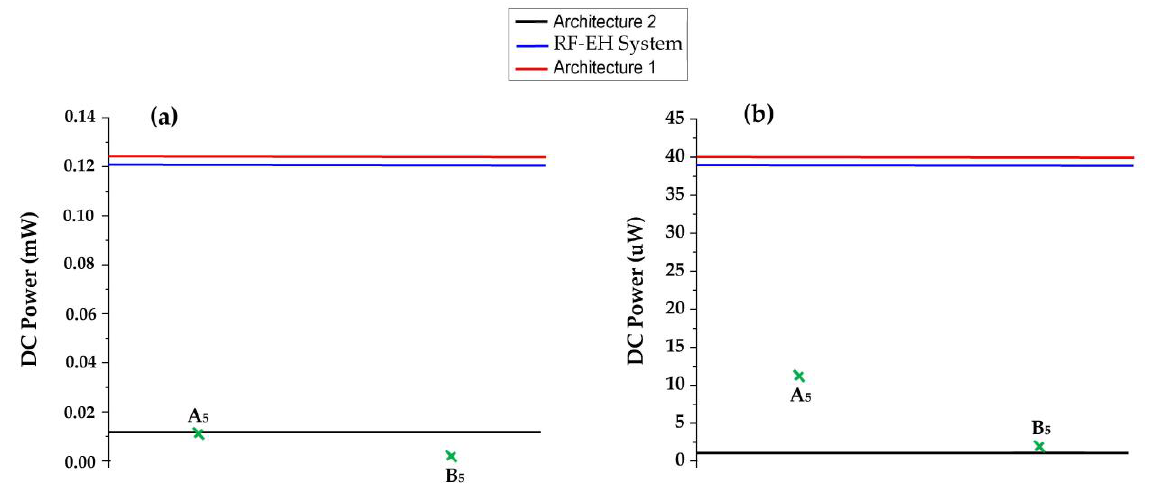
Figure 35. Feeding ability of the proposed system and architectures at ( a ): 110 m, ( b ): 122 m from relay antenna compared to minimum required power supply of the temperature sensors. The DC powers A 5 and B 5 correspond to the power supply of sensors reported in the references [45,46], re- spectively .